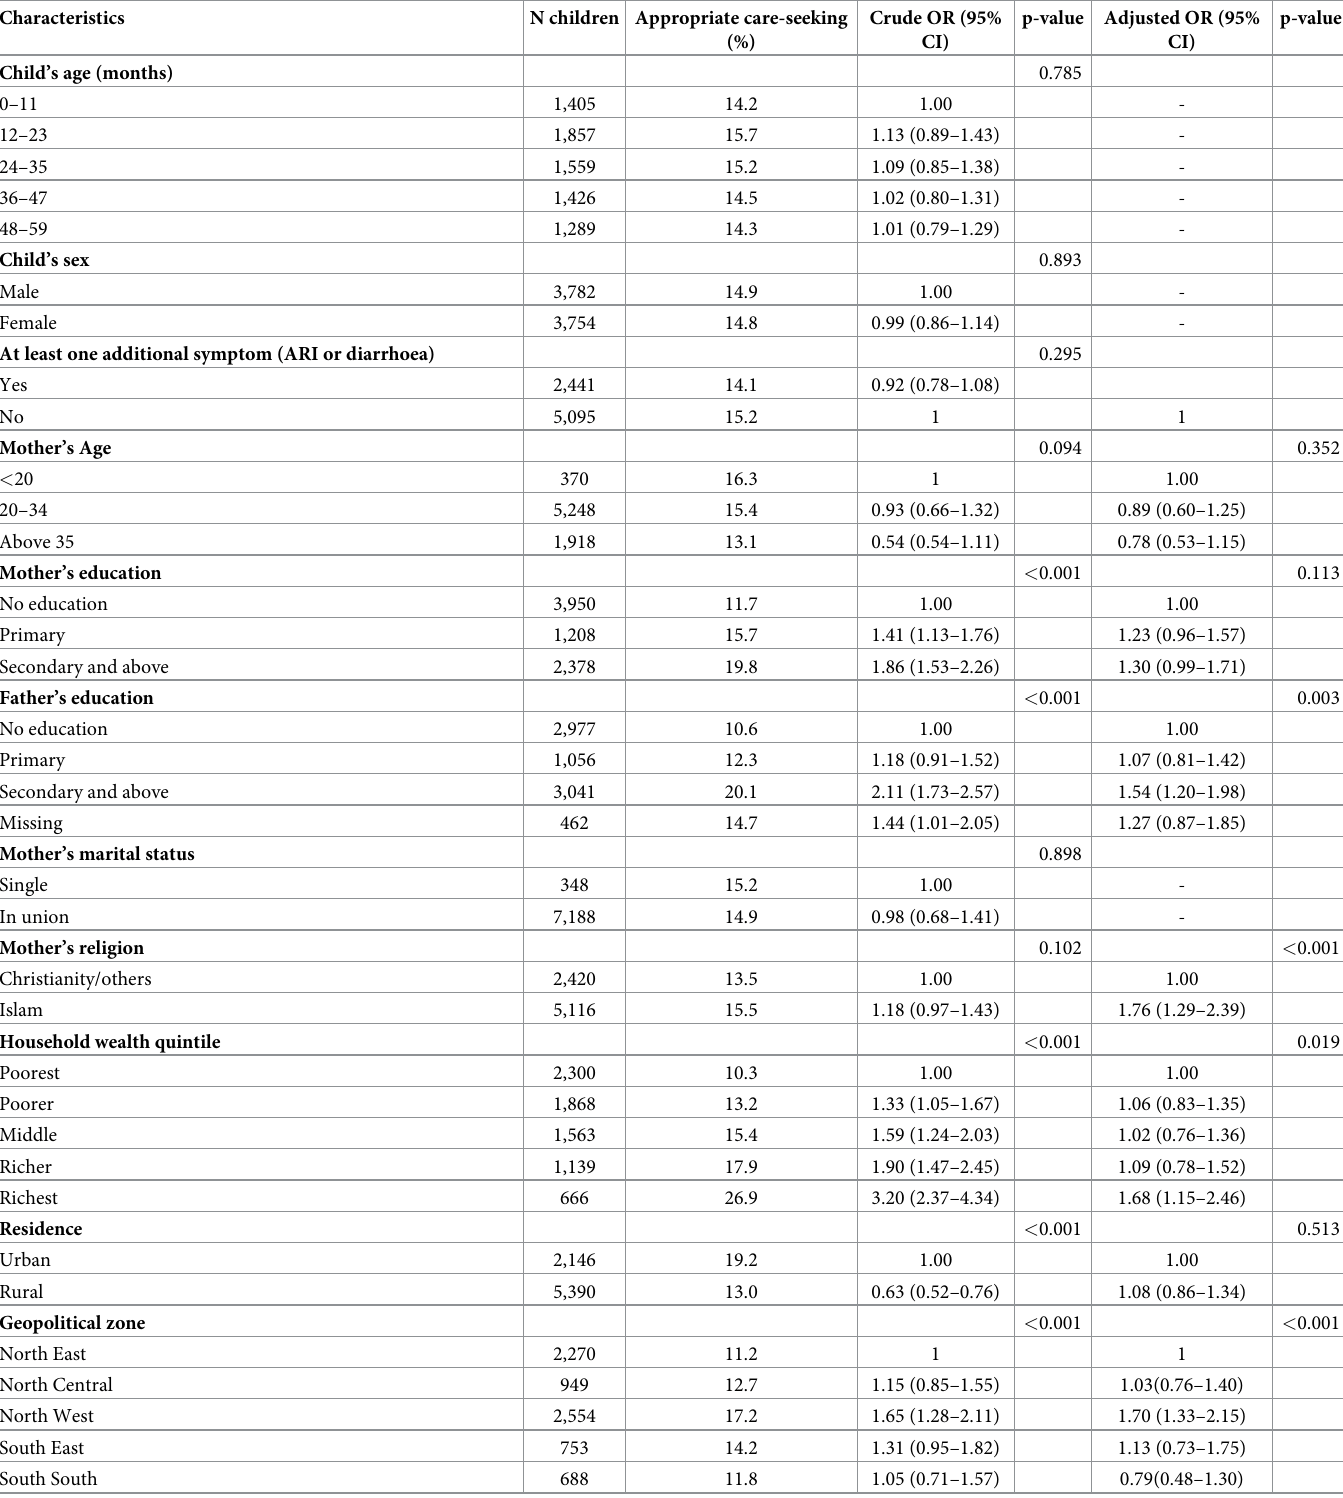
Table 3. Logistic regression analysis of factors associated with appropriate care-seeking behaviour for children under five with fever (N = 7,536).